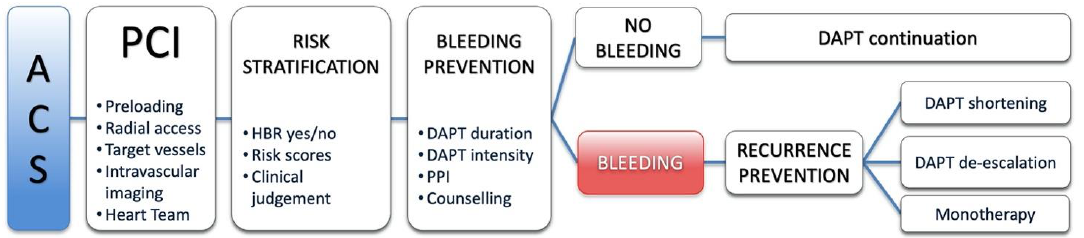
Figure 1. Critical points in decision making when choosing an antiplatelet strategy and managing related bleedings. PCI, percutaneous coronary intervention; DAPT, dual antiplatelet therapy; ACS, acute coronary syndrome; HBR, high bleeding risk; PPI, proton pump inhibitors.